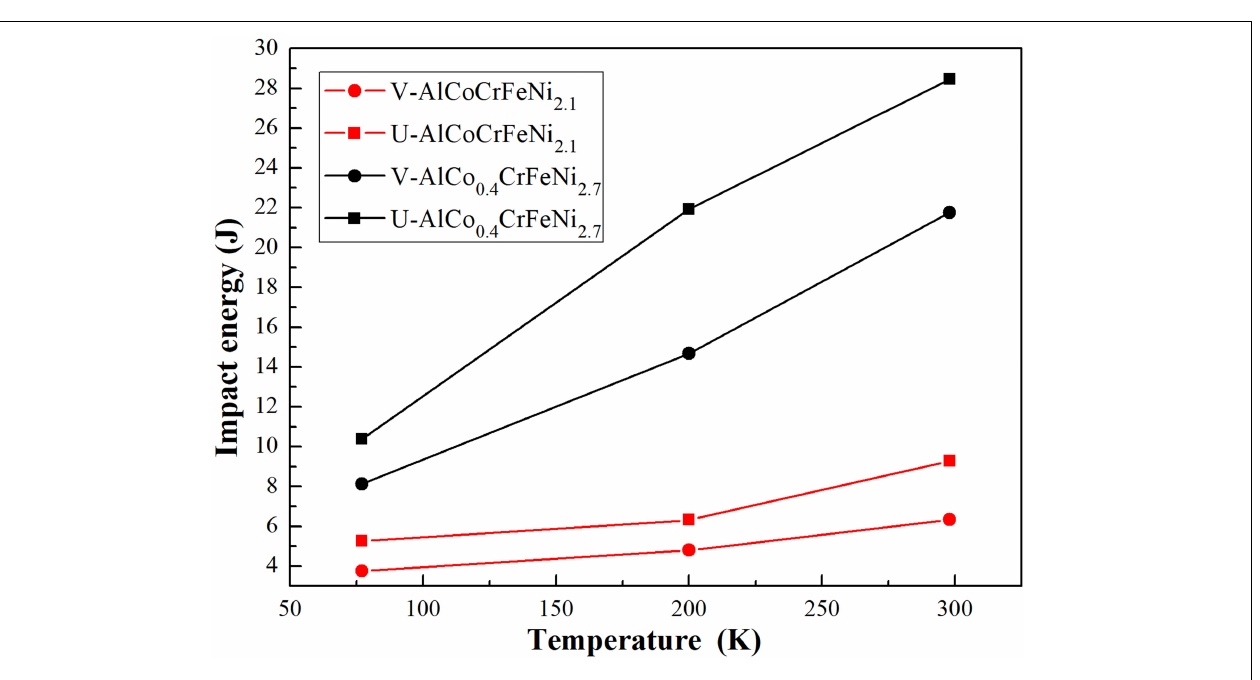
FIGURE 6 | The impact energy as a function of different test temperatures.